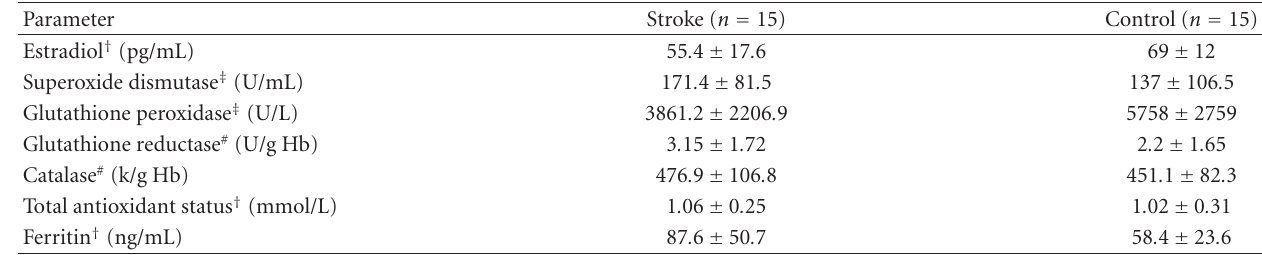
Table 3: The mean ± SD values of the estradiol, ferritin and total antioxidant status, superoxide dismutase and glutathione peroxidase, glutathione reductase and catalase of the females from stroke and control